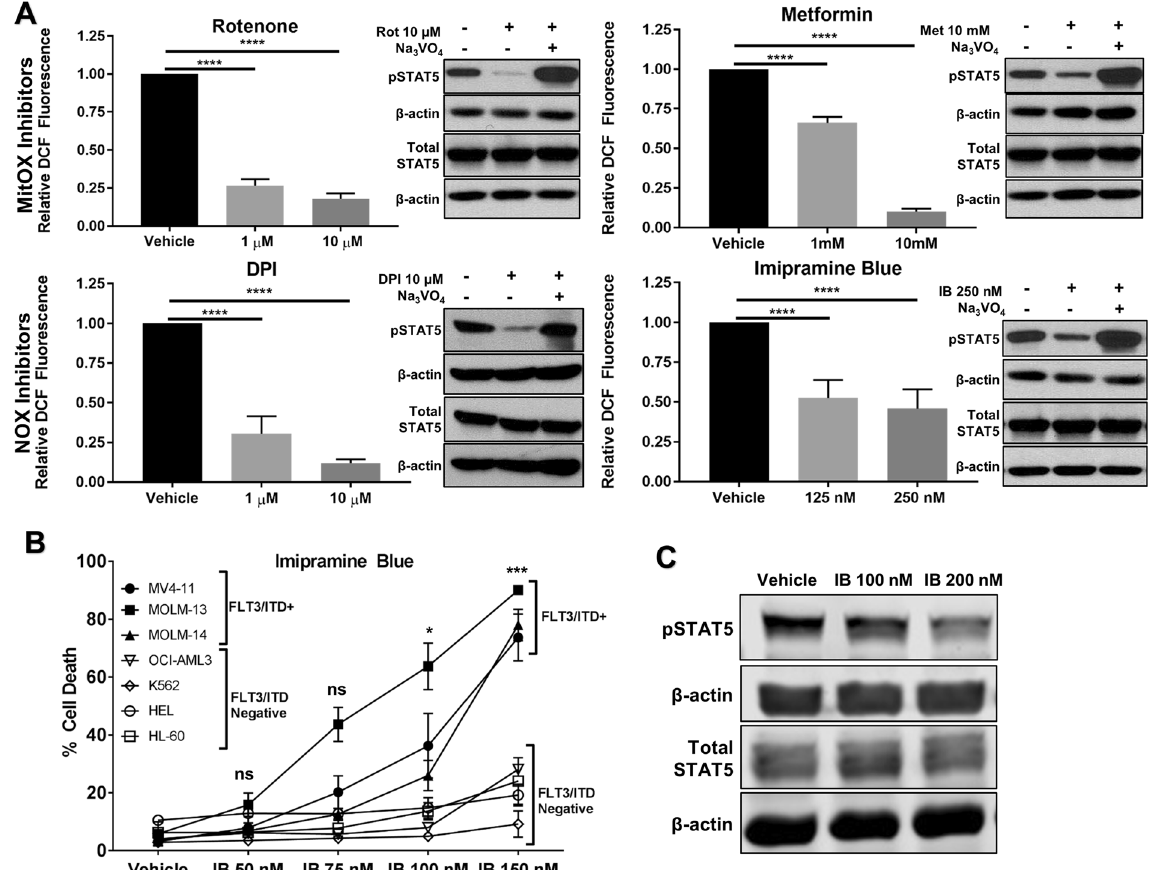
Figure 1. Imipramine blue selectively kills FLT3/ITD + AML cell lines at lower concentrations than required to suppress STAT5 phosphorylation. ( A ) MV4–11 cells were treated with mitochondrial complex I inhibitors (rotenone and metformin) or NOX inhibitors (DPI and imipramine blue) for 4 hours prior to 30 minute H2- DCF-DA staining and flow cytometry. For Western blots, MV4–11 cells were treated for 4 hours with or without 1 mM PTP inhibitor sodium orthovanadate (Na 3 VO 4 ). MitOX inhibitors decreased pSTAT5, and this effect was reversed in the presence of Na 3 VO 4 , indicating PTP liberation as the cause of decreased pSTAT5. ( B ) Trypan blue exclusion assay after 48 hours drug exposure. FLT3/ITD + cell lines were selectively killed at nM doses of IB, specifically 100–150 nM. ( C ) Doses of 200 nM IB were required to see significant inhibition of pSTAT5. The original uncropped Western blot files are included as Supplemental material. ( * p < 0.05, *** p < 0.001, **** p < 0.0001, ns: p >